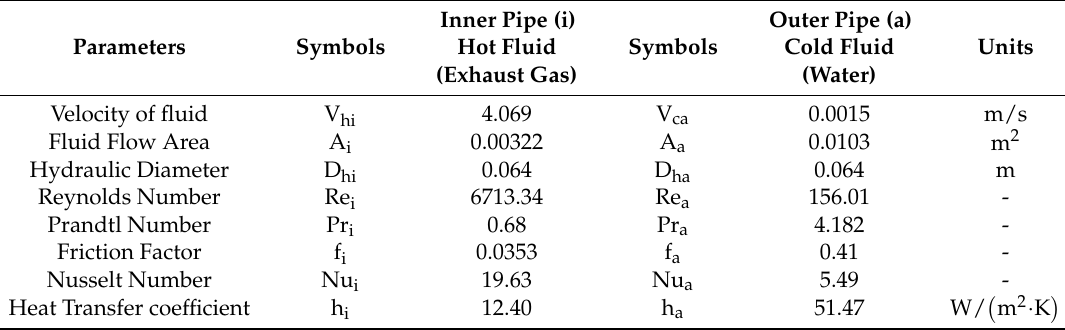
Table 4. Heat transfer calculation parameters for heat